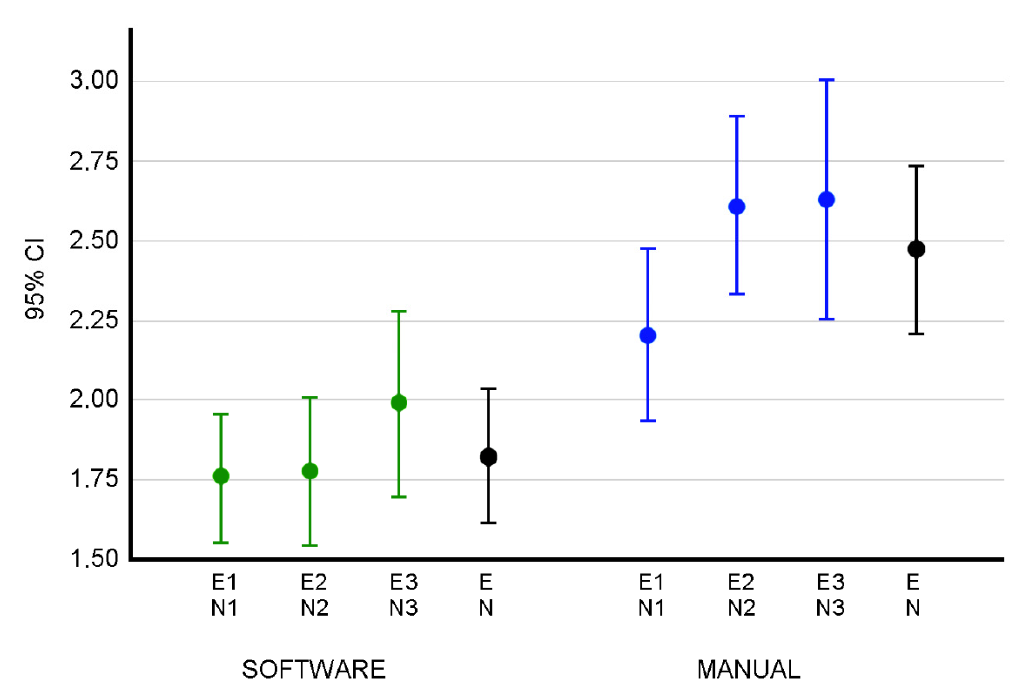
Figure 3. The 95% confidence intervals of the inter-group MBEs. The letter E identifies the measurements obtained by the group of expert observers. E1, E2, and E3 represent the measurements obtained by the group of expert observers in the first, second, and third rounds of measurements, respectively. The letter N identifies the measurements obtained by the group of novice observers. N1, N2, and N3 represent the measurements obtained by the group of novice observers in the first, second, and third rounds of measurements, respectively. Intervals are shown for MBE in the error distribution E1N1 (between the first batch of experts and the first round of novices), E2 N2, E3N3, and EN (interval for the inter-group MBE when considering the three rounds of expert and novice measurements). Confidence intervals are shown for the error distributions of the measurements obtained both with the software and manually, where EN is the distribution of inter-group errors in the three measurement rounds of the expert (E) and novice (N) groups. In green, the inter-group measurement errors when measuring with the software between measurement rounds 1, 2 and 3. In blue, inter-group errors when measuring manually between measurement rounds 1, 2 and 3. In black, the inter-group errors when considering the set of the three tests.